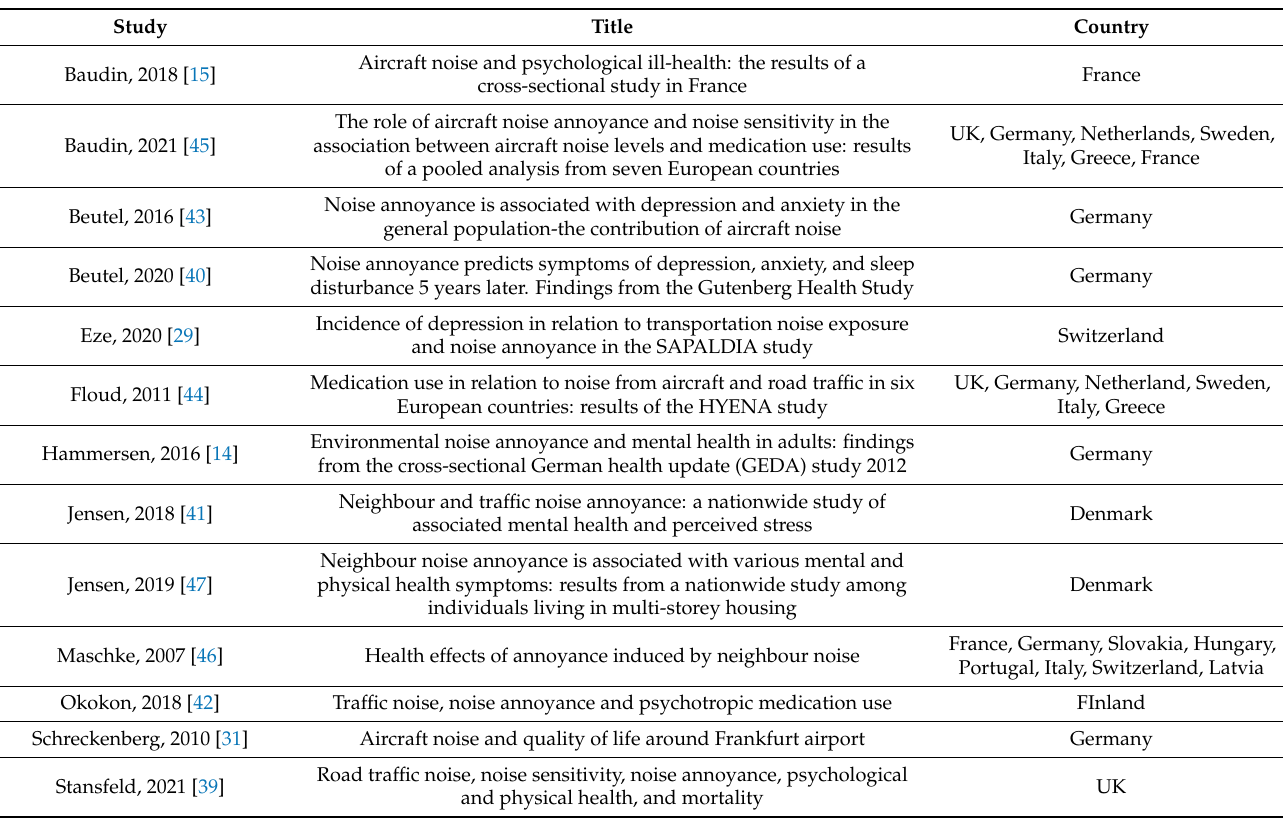
Table A4. List of studies included in the analyses.